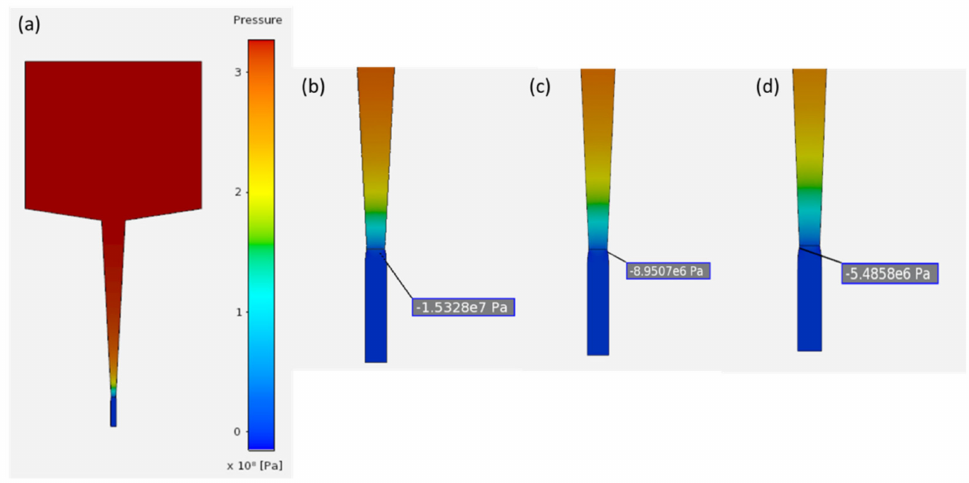
Figure 12. Pressure distribution of rice paste with different nozzle sizes: ( a ) fluid domain, ( b ) nozzle size 0.8 mm, ( c ) nozzle size 1.0 mm, and ( d ) nozzle size 1.2